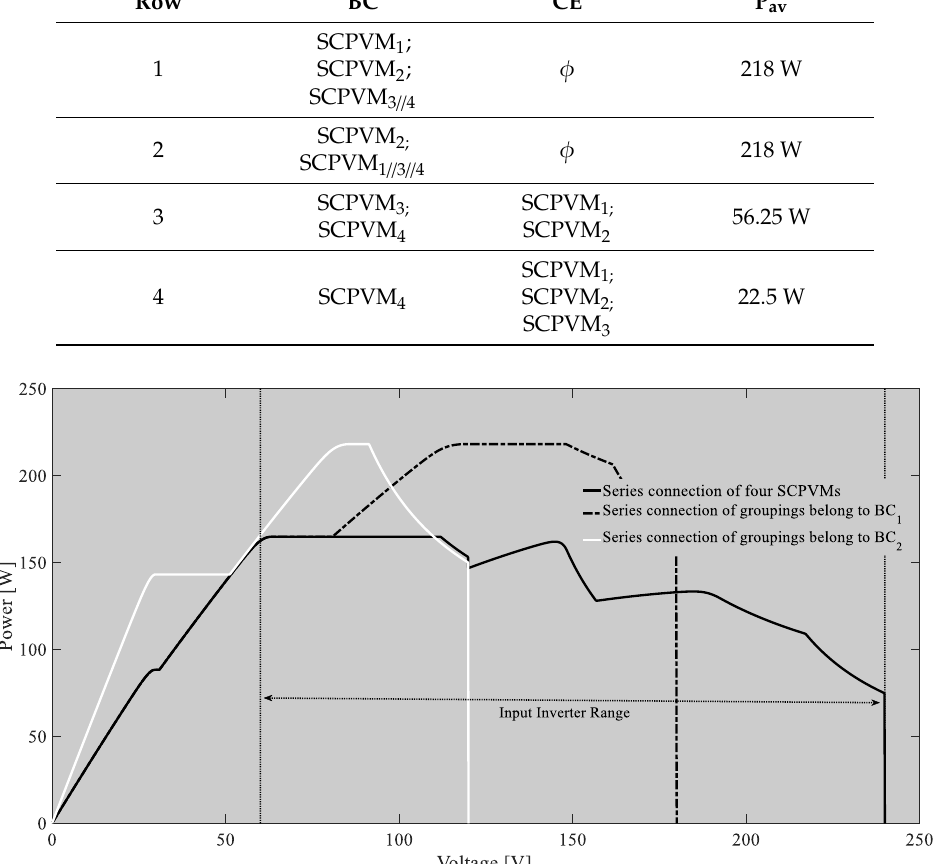
Figure 16. P-V characteristics (CASE II).